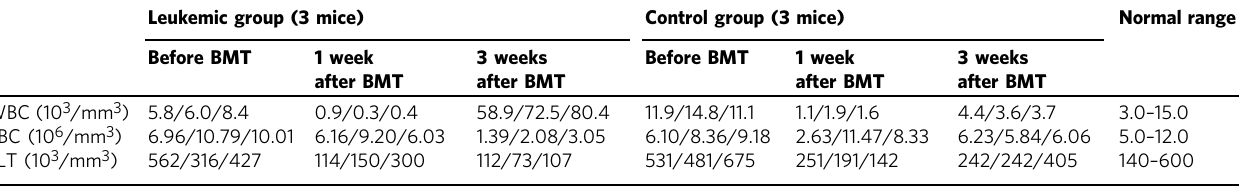
Table 1 CBC tests for mice at different time points.